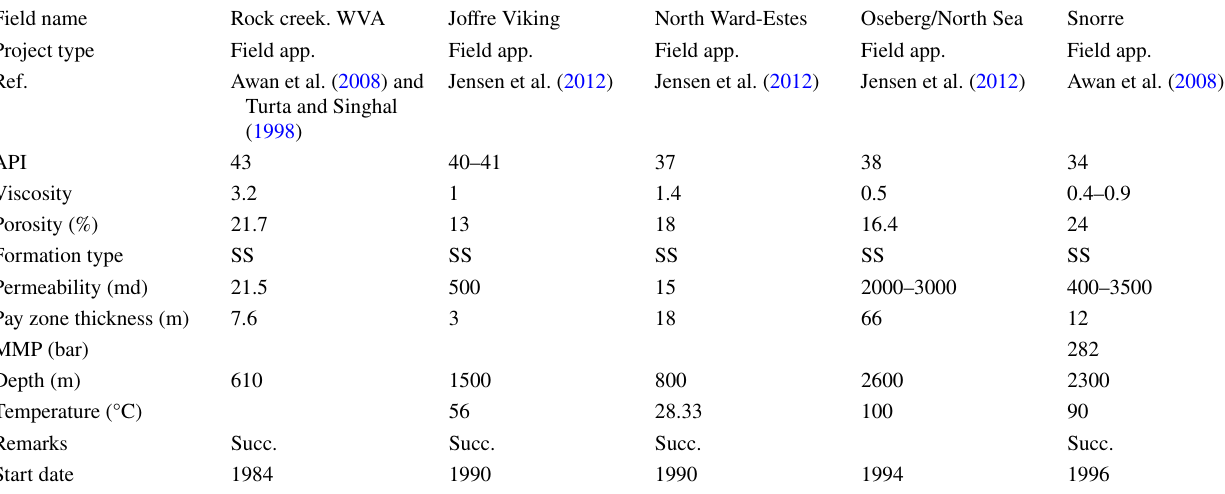
Table 6 Reservoir data for successful FAWAG projects Field